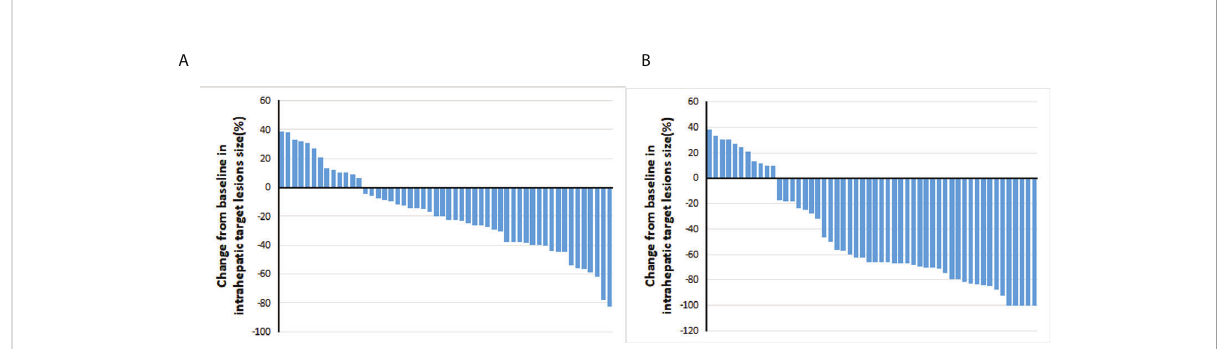
FIGURE 3 Best percentage changes from baseline in the size of the intrahepatic target lesions of patients receiving atezolizumab plus bevacizumab combined with HAIC. (A) Assessed with RECIST1.1 in patients with image measurements before and after treatment. (B) Assessed with mRECIST in patients with image measurements before and after treatment.